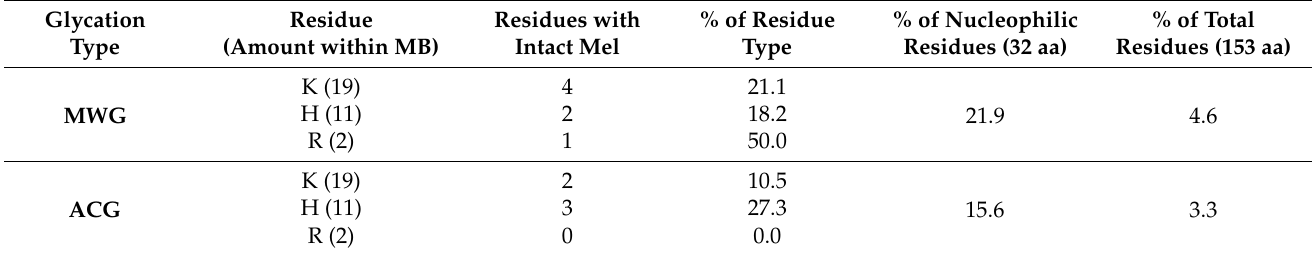
Table 4. Summary of the nucleophilic amino acid residues modified with intact mel.